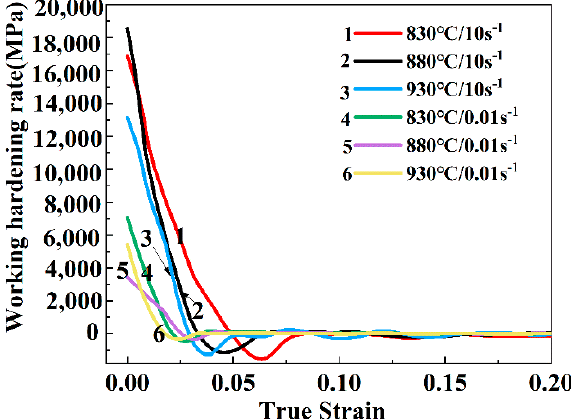
Figure 17. The curves of work hardening rates of Ti-35421 alloys at different deformation conditions.